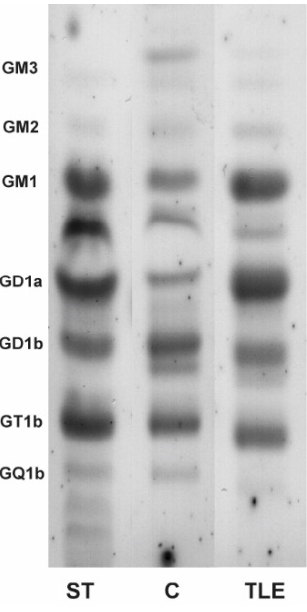
Figure 3. ( − ) NanoESI HR MS of ganglioside mixture derived from control hippocampal tissue sample. Conditions as in Figure 2.